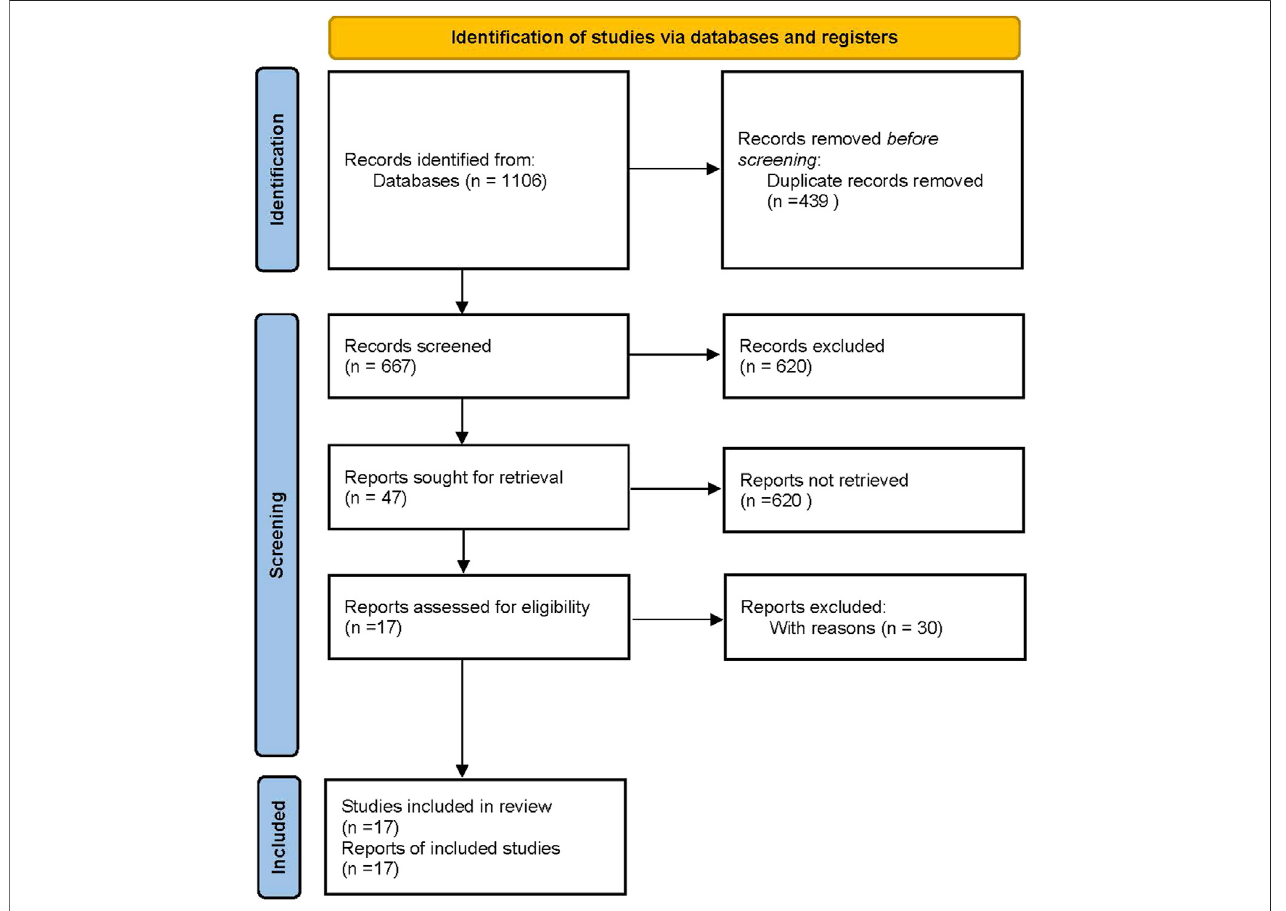
FIGURE 1 | Flow diagram of meta-analysis generated by PRISMA 2020 (Haddaway et al., 2021).